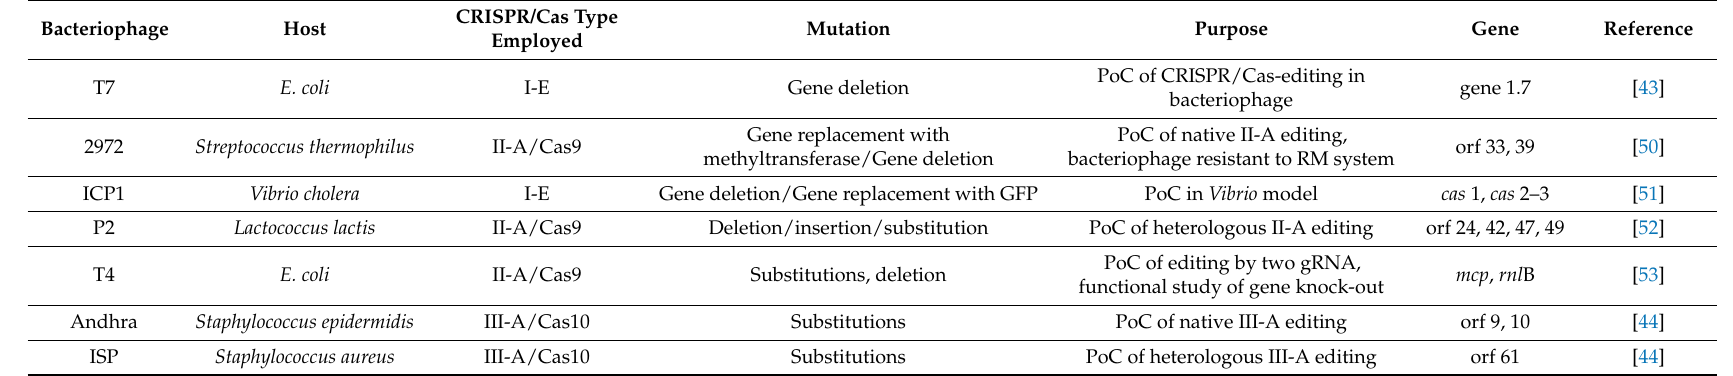
Table 4. Summary of Clustered Regularly Interspaced Short Palindromic Repeats/CRISPR associated systems (CRISPR/Cas) applications in the editing of